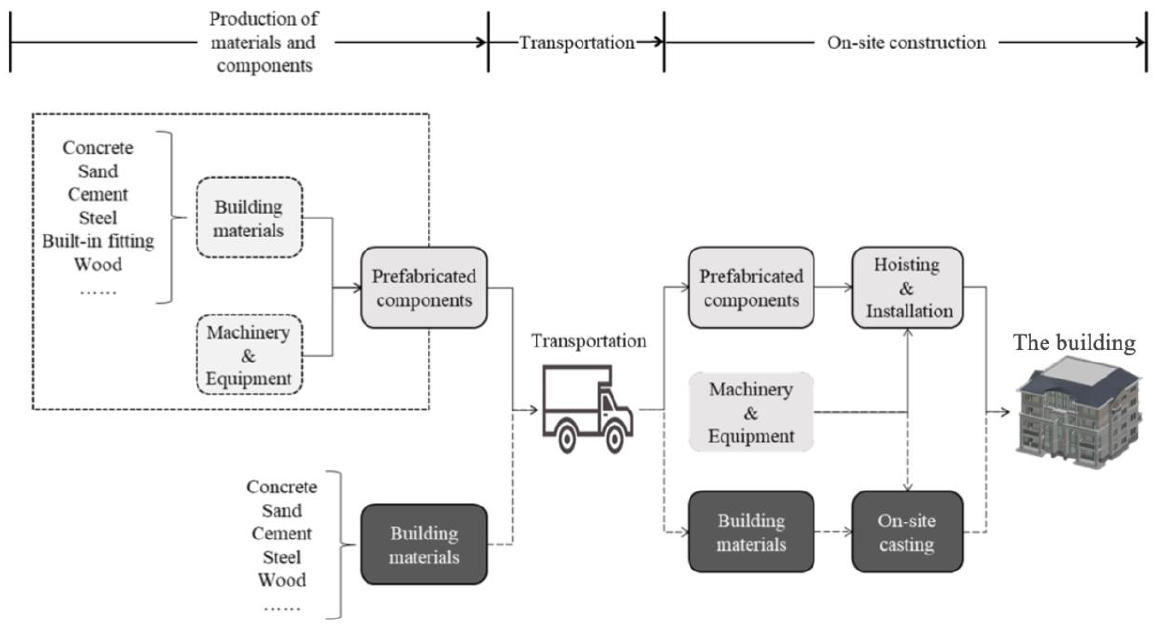
Figure 1. Three Phases of the Construction